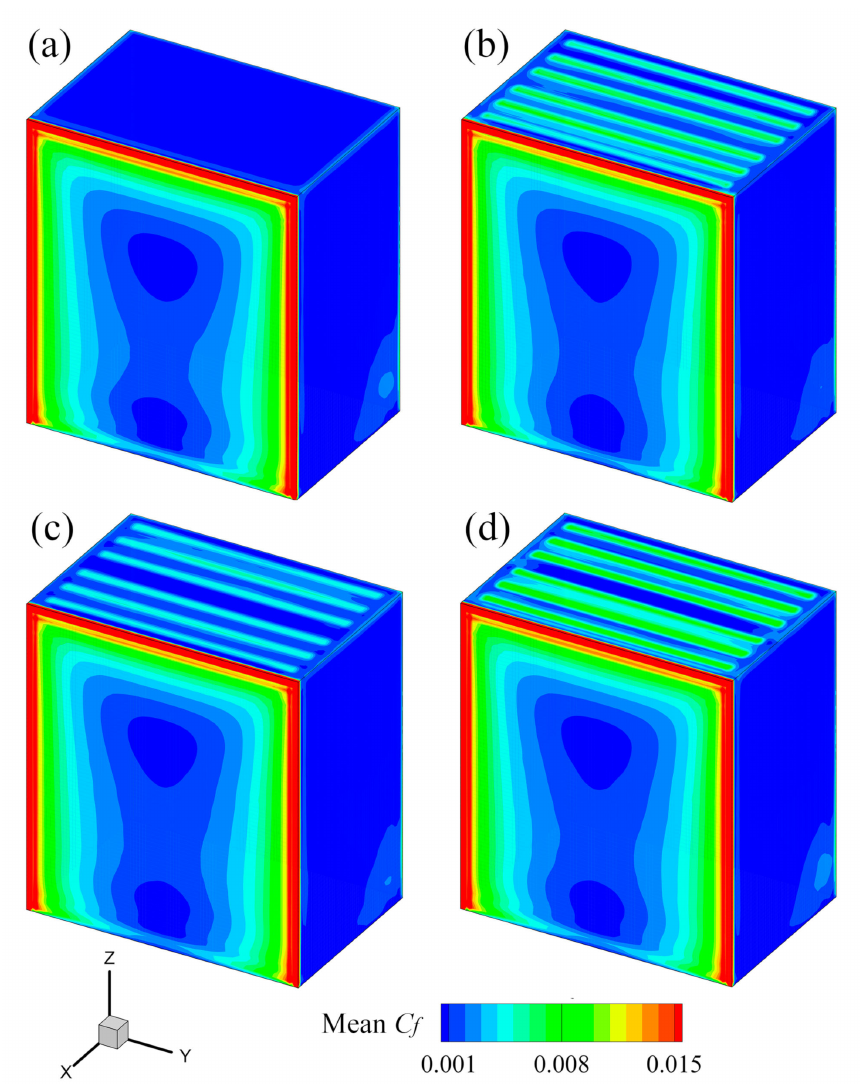
Figure 18. Contours of mean skin friction coe ffi cients on the building surfaces with di ff erent cases. ( a ) no actuation; ( b ) case A; ( c ) case B; ( d ) case